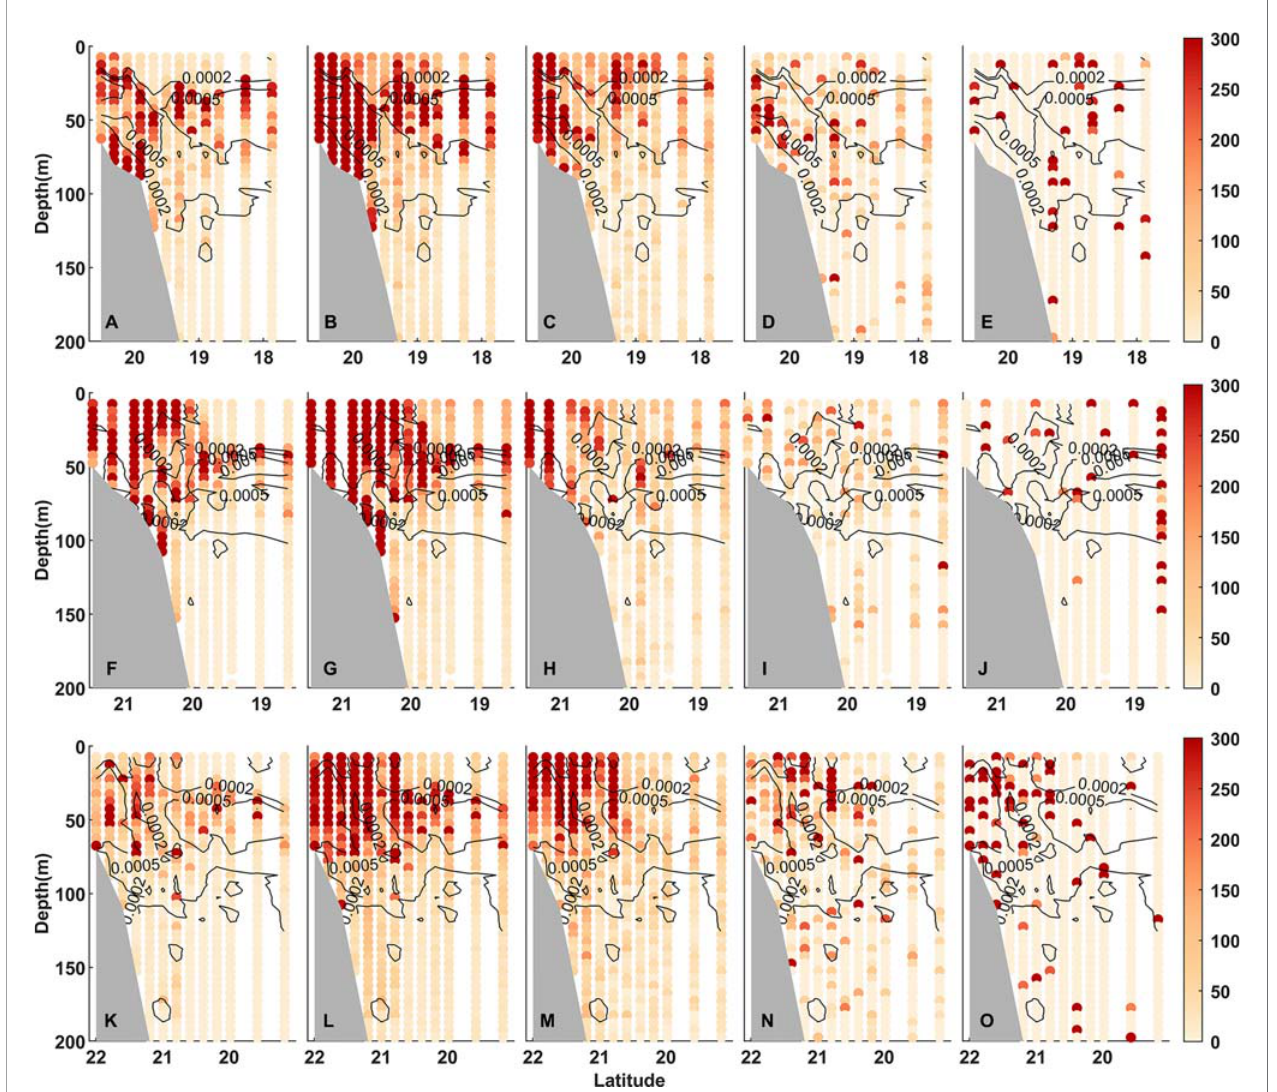
FIGURE 6 | Contours are Brunt-Väisälä frequency (s − 2 ) and solid circles are biovolume (mm 3 /m 3 ) of fi ve size groups [ (A, F, K) 0.1 – 0.2 mm, (B, G, L) 0.2 – 0.5 mm, (C, H, M) 0.5 – 1.0 mm, (D, I, N) 1.0 – 2.0 mm, and (E, J, O) >2.0 mm] along transect S1 (upper panel), S2 (middle panel), and S3 (lower